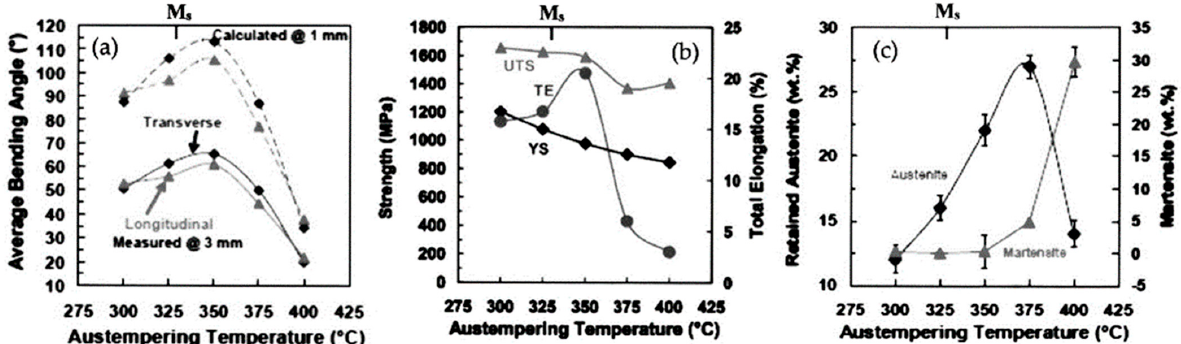
Figure 17. Variations in ( a ) average bending angle, ( b ) yield stress (YS), ultimate tensile strength (UTS), and total elongation (TE), and ( c ) volume fractions of retained austenite and martensite as a function of austempering temperature in 0.34C-1.65Si-1.94Mn-1.07Cr CFB steel [29]. M s of the steel is 329 °C.